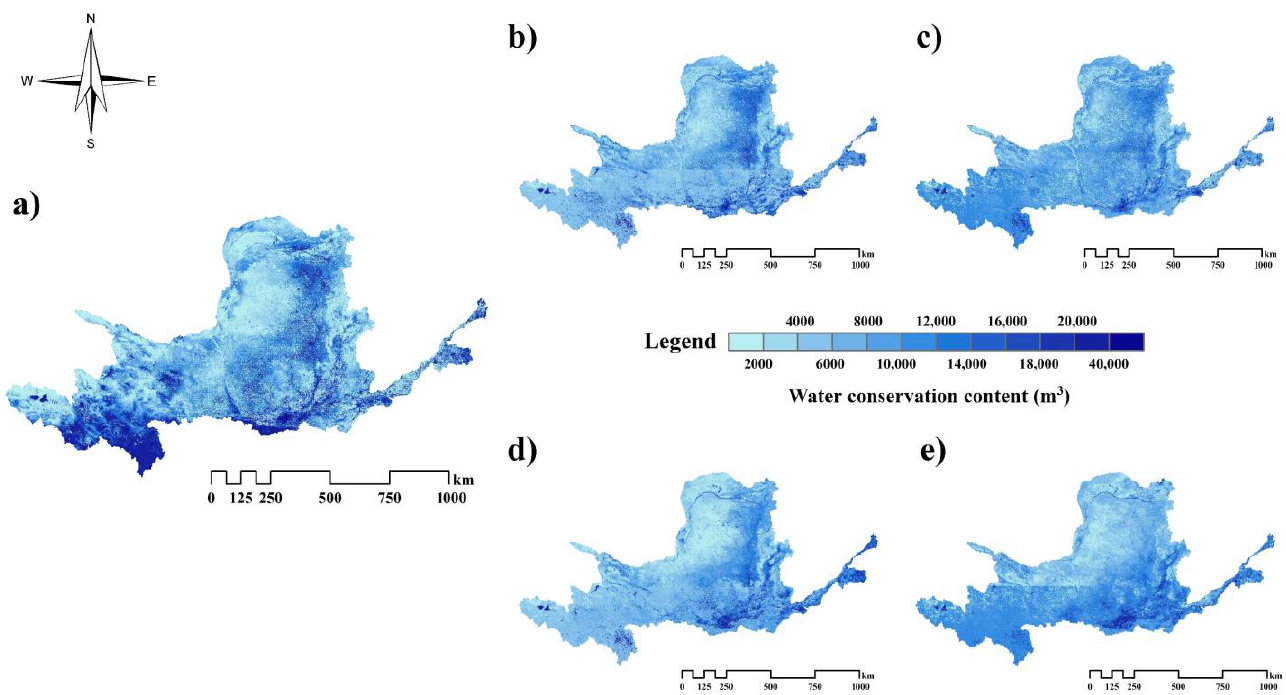
Figure 9. Spatial distribution of the estimated water conservation by: ( a ) the original water conservation formula, ( b ) the stratified method using a support vector machine (SVM), ( c ) the stratified method using partial least squares regression (PLSR), ( d ) the overall method using an SVM, and ( e ) the overall method using PLSR.